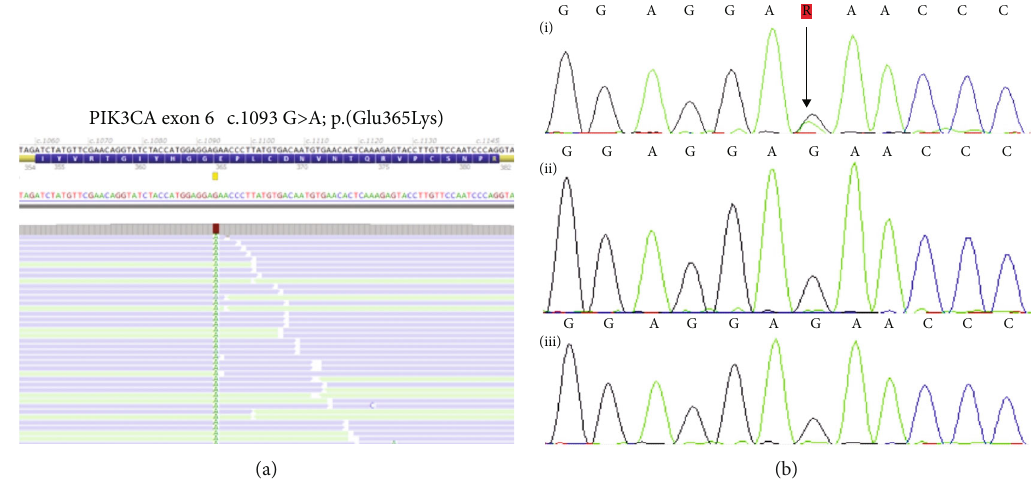
Figure 2: Identi fi cation of a mosaic PIK3CA missense mutation in a gingival biopsy. (a) Next-generation sequencing (NGS) of the gingival biopsy sample identi fi ed a missense mutation in exon 6 of the PIK3CA gene, as indicated by the yellow square. Twenty-two percent of reads showed the G > A change (324/1475 reads, 174+ 150-), suggesting a potential mosaic mutation. (b) Direct Sanger sequencing of 3 independent samples from the patient con fi rmed the presence of the missense mutation in the (i) gingival biopsy sample and showed the absence of this mutation in the (ii) blood and (iii) saliva samples, supporting the hypothesis of a mosaic